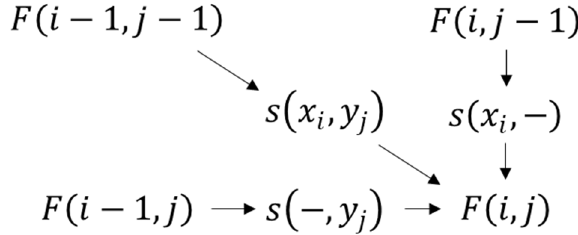
Figure 1. Three paths to fill the matrix.